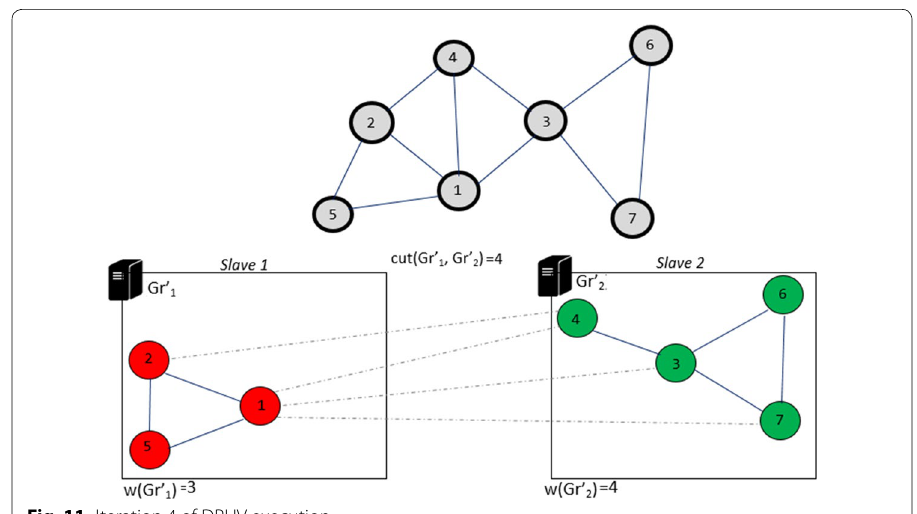
Fig. 11 Iteration 4 of DPHV